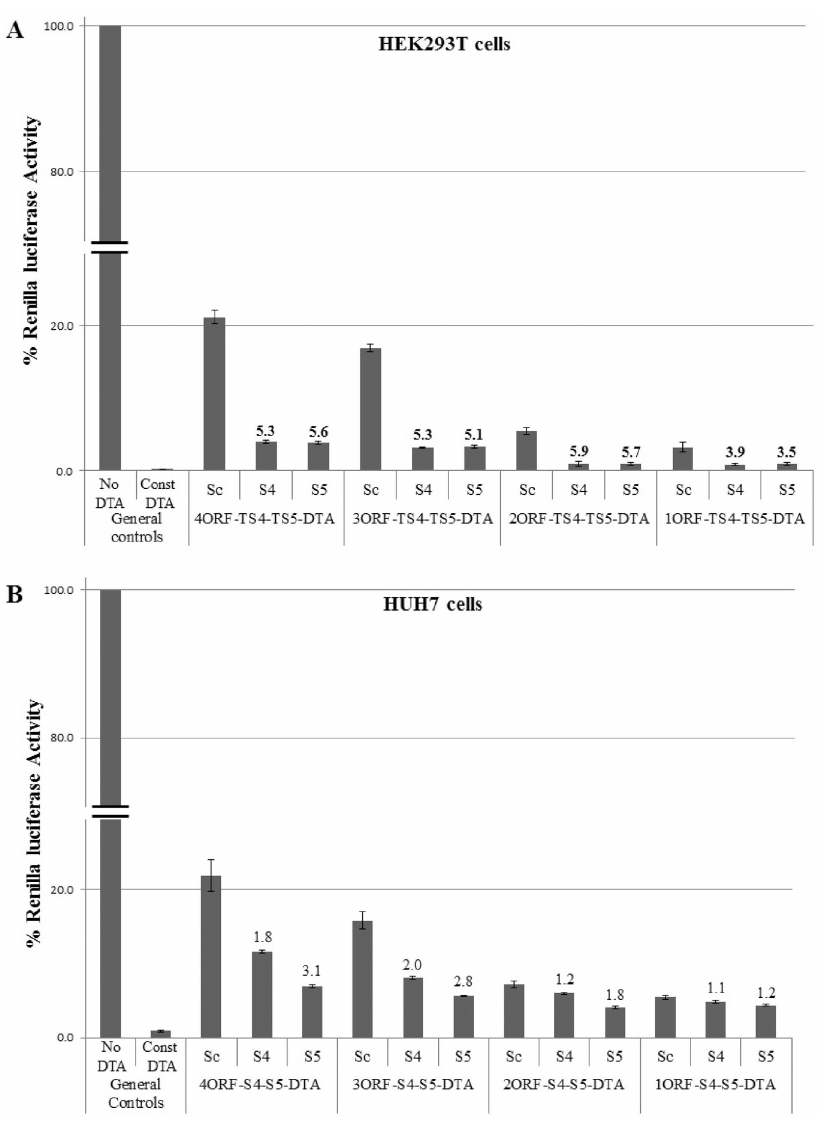
Fig. 2. Transgene activation by siRNAs in constructs containing varied numbers of upstream ORFs. (A) Activity of the constructs in HEK293T cells. (B) Activity of the constructs in HUH7 cells. HEK293T cells (1.1 6 10 5 ) were transfected with the indicated DTA construct (30 ng), a luciferase reporter plasmid (170 ng) and the indicated siRNA (10 pmol). HUH7 cells (8 6 10 4 ) were transfected with the indicated DTA construct (50 ng), a luciferase reporter plasmid (150 ng) and the indicated siRNA (10 pmol). The renilla luciferase activity of the ‘‘No DTA’’ construct was set as 100% and the luciferase activity obtained for all other constructs were compared to the No DTA level. All constructs had the CMV promoter. The ‘‘No DTA’’ construct had the UIR but had no transgene. The ‘‘Const DTA’’ construct had no UIR, with the DTA transgene directly driven by the CMV promoter. The siRNAs used were: Sc: control siRNA; S4: siRNA S4; S5: siRNA S5. The numbers above the bars of the S4 and S5 siRNA indicated the DTA induction level calculated by dividing the luciferase activity of the Sc siRNA with that of the S4 or S5 siRNA of the same set. The experiments were repeated twice and each experiment was done in triplicates. Statistical analysis was done by T-test and the bars represent standard error. P values in A were 0.005; 2*10( 2 19); 2*10( 2 21) for 2ORF, 3ORF and 4ORF respectively. P values in B were 0.008; 6*10( 2 11); 6*10( 2 12) for 2ORF, 3ORF and 4ORF respectively. In both cases comparison was to the siRNA controls